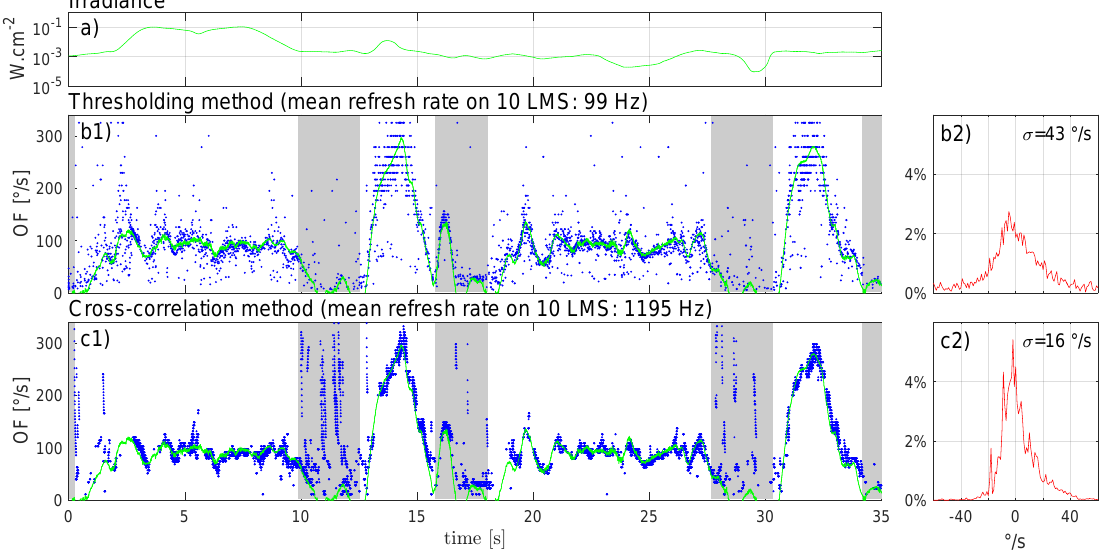
Figure 9. ( a ) Light intensity in W · cm − 2 measured with a photodiode oriented in the same direction as the M 2 APix sensor embedded under the X4-MaG; ( b , c ) In the left panels ( b1 , c1 ), blue points represent single-LMS OF measurements; the green line is the ground-truth provided by high-precision Vicon tracking. Right panels ( b2 , c2 ) present the OF error distribution, with 1°/s beams in the [300°/s; 300°/s] range, with respect to the ground-truth during forward drone movement (white zones in left panels). The excluded (gray) zones correspond to periods of pure yaw rotation during the MAV trajectory. See Supplemental Movie 1 to watch the